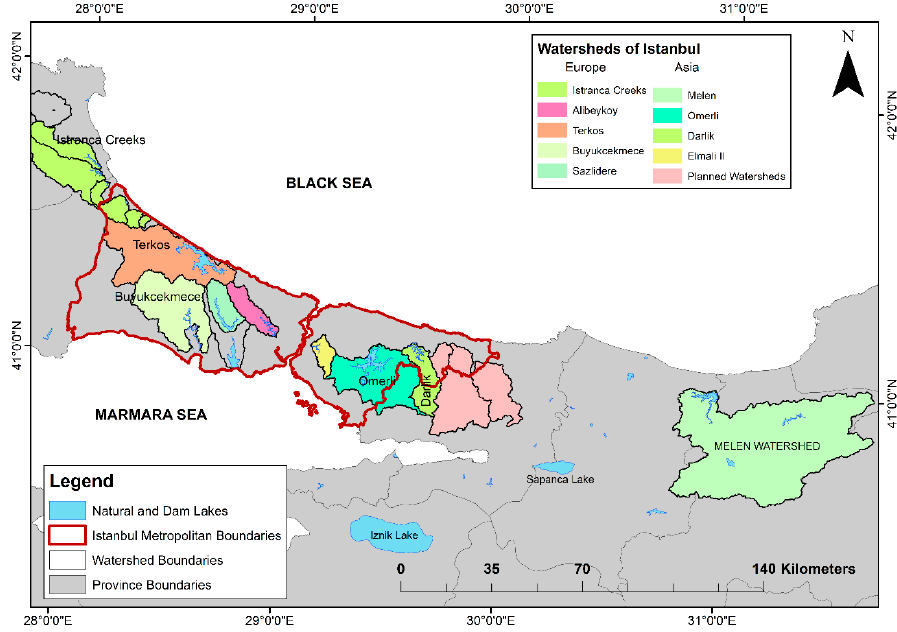
Figure 3. Watersheds used to supply drinking water located both in the Asian and European sides of Istanbul, with administrative boundaries over the region.